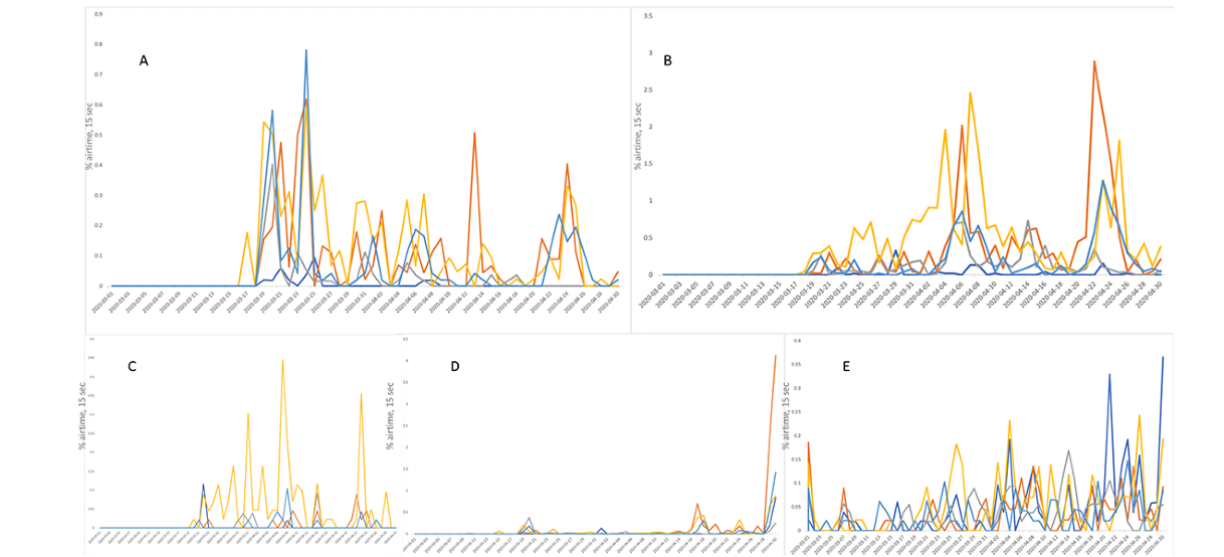
Figure 1. Television airtime of keywords from March 1 to April 30, 2020 during 15-second airtime blocks. Dark blue represents BBC News, orange represents CNN, grey represents C-SPAN, yellow represents Fox News, and light blue represents MSNBC. (A) Airtime for the term "chloroquine". (B) Airtime for the term "hydroxychloroquine." (C) Airtime for the term "azithromycin." (D) Airtime for the term "remdesivir". (E) Airtime for the term "covid treatment". CNN: Cable News Network; C-SPAN: Cable-Satellite Public Affairs